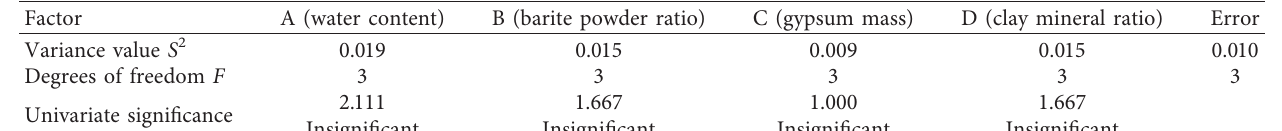
Table 17: Variance analysis of Poisson’s ratio.